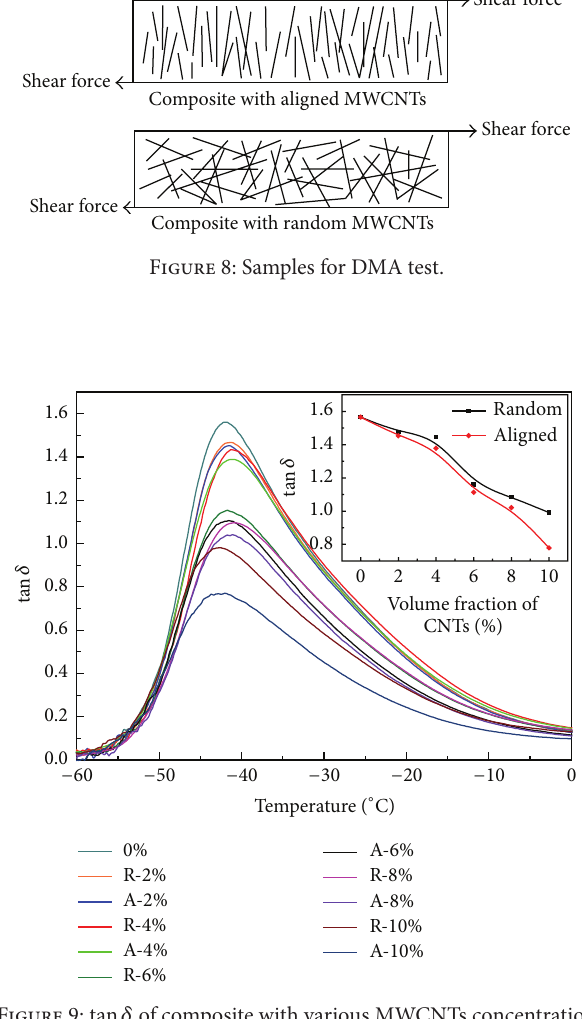
Figure 9: tan 𝛿 of composite with various MWCNTs concentration before and after